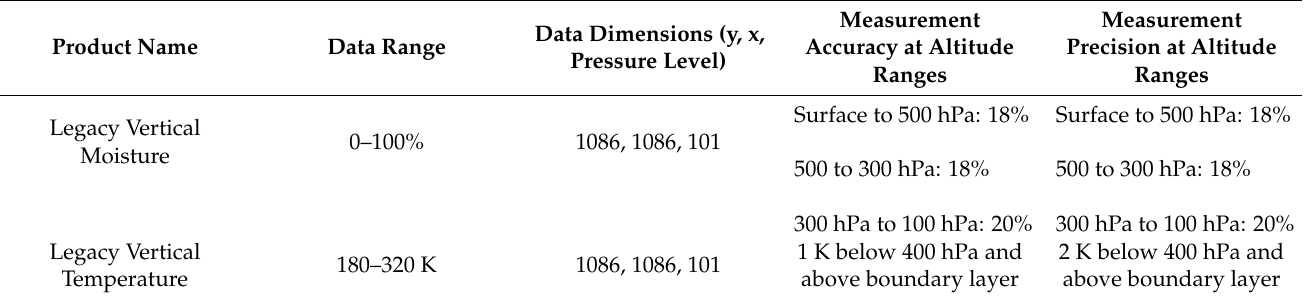
Table 1. Model imaging Cartesian coordinate bounds